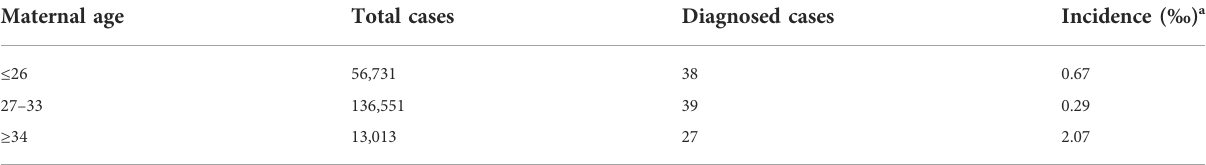
TABLE 2 Incidence of DS by maternal age groups. Maternal